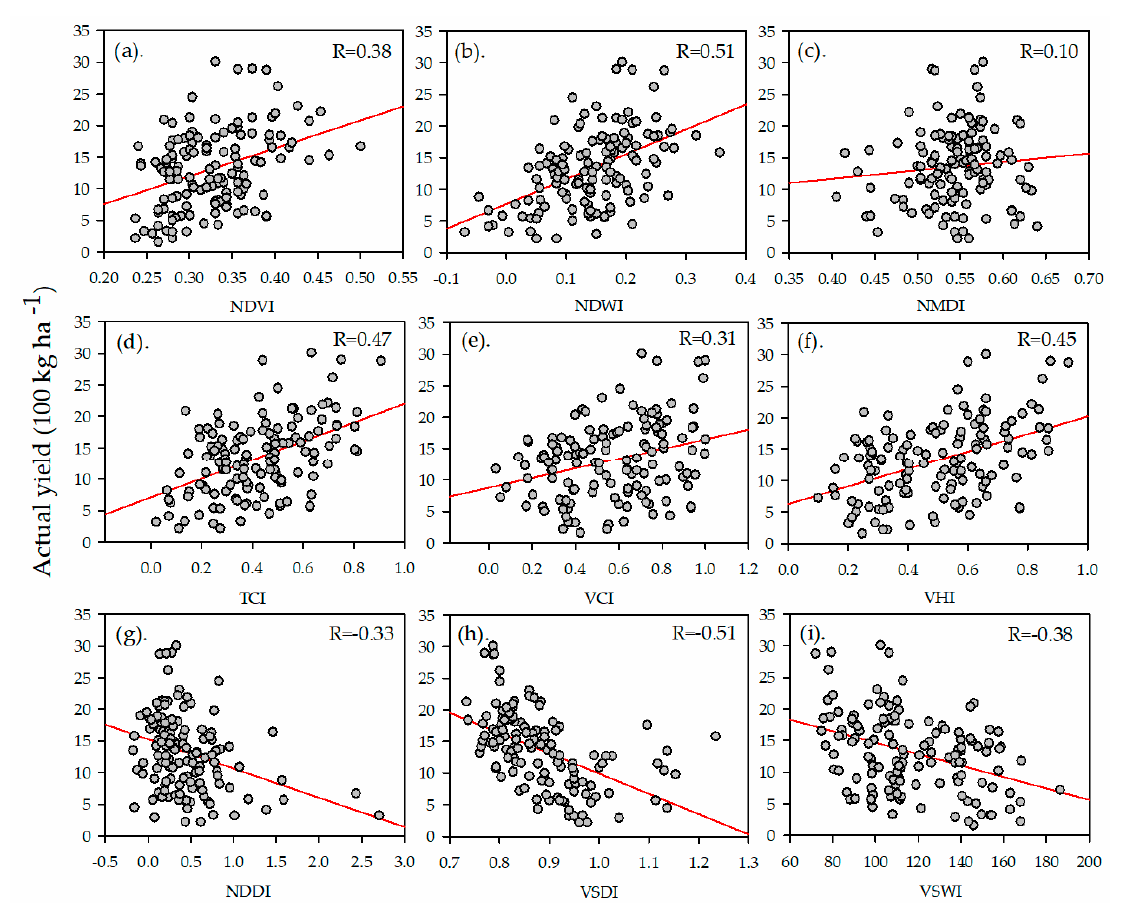
Significant at highlighted values = p < 0.05, Number of samples = 126 − 134 ((Due to the clouds or error data of satellite images there were some 10days of some indices are missed). Remote Sens. 2019 , 11 , x FOR PEER REVIEW